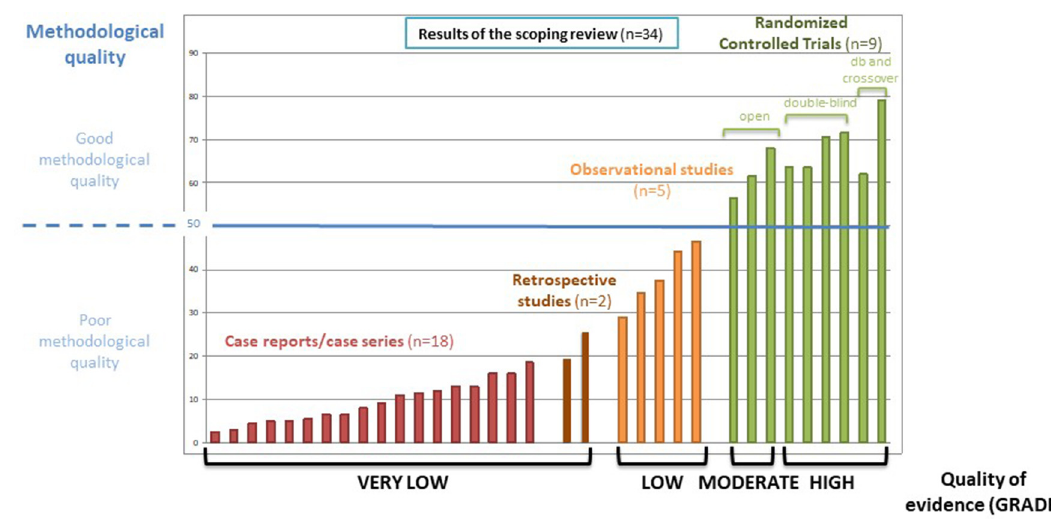
Fig. 2. Distribution of selected studies following the scoping review (db = double-blind).